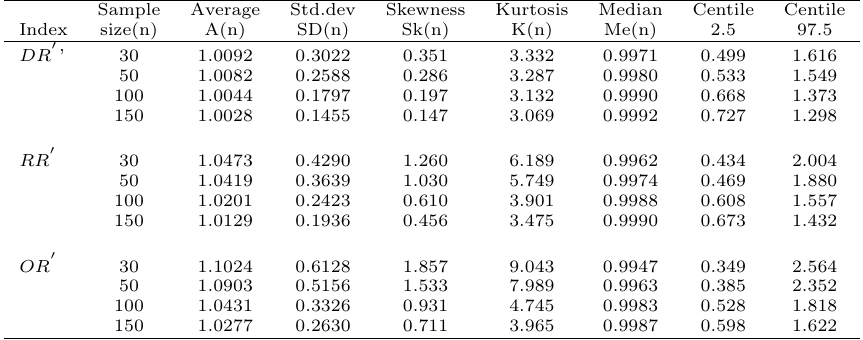
′ ′ ′ , RR , OR for some values of n